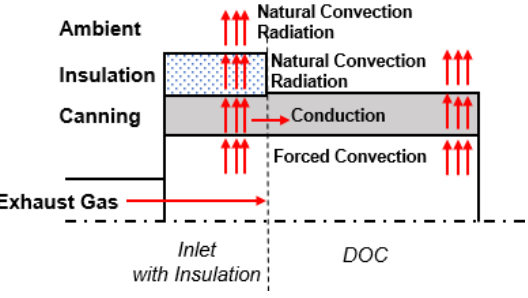
Figure 4. Aftertreatment inlet heat transfer model scheme.